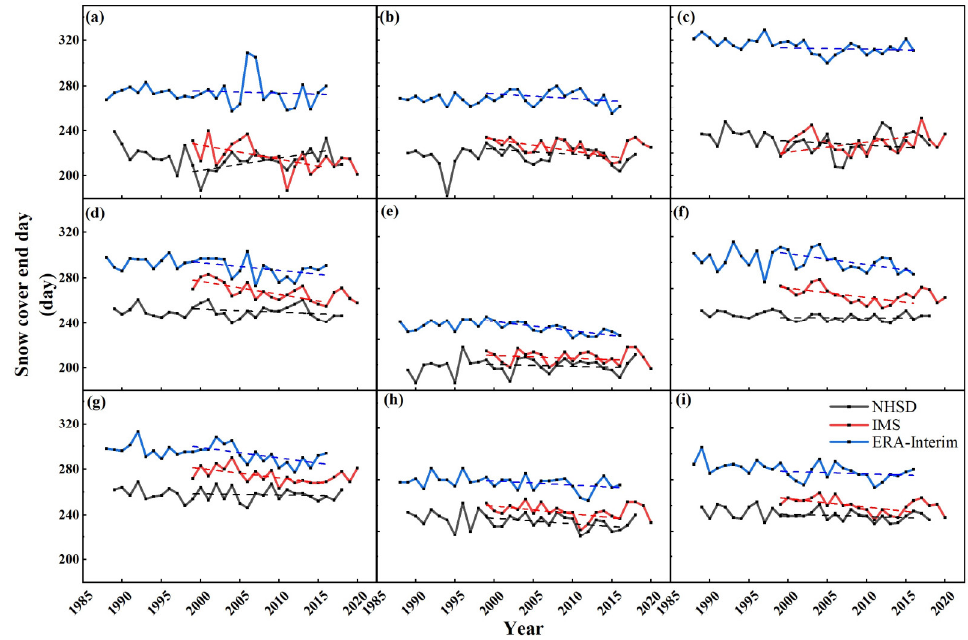
Figure 13. Comparison of the SCED derived from NHSD, IMS, and ERA-Interim in typical areas. The typical areas are ( a ) the Alps, ( b ) the Rocky Mountains, ( c ) the Qinghai–Tibet Plateau, ( d ) Alaska, ( e ) the Eastern European Plain, ( f ) the Eastern Siberian Mountains, ( g ) Northern Canada, ( h ) the West Siberian Plain, and ( i ) the Central Siberian Plateau.